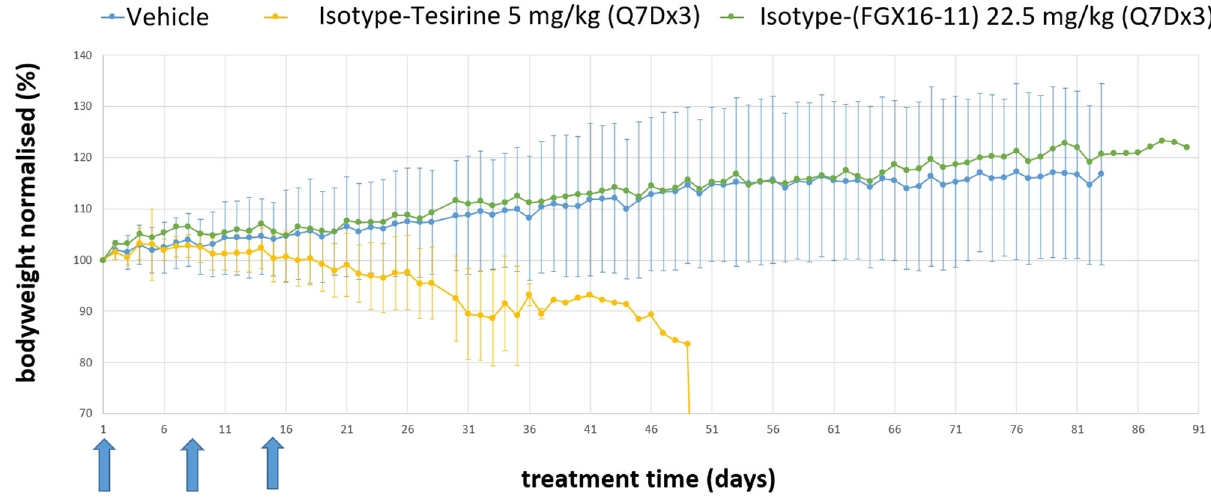
Fig. 8 In vivo tolerability study showing the effect of the non-targeting Isotype-(FGX16-11) ADC dosed at 22.5 mg/kg every seven days (Q7Dx3) on the body weight of mice out to 90 days. Data for the equivalent Isotype-tesirine ADC dosed at 5 mg/kg (Q7Dx3) is shown for comparative purposes. The blue arrows represent the Q7Dx3 dosing points ( n = 6 mice per cohort).